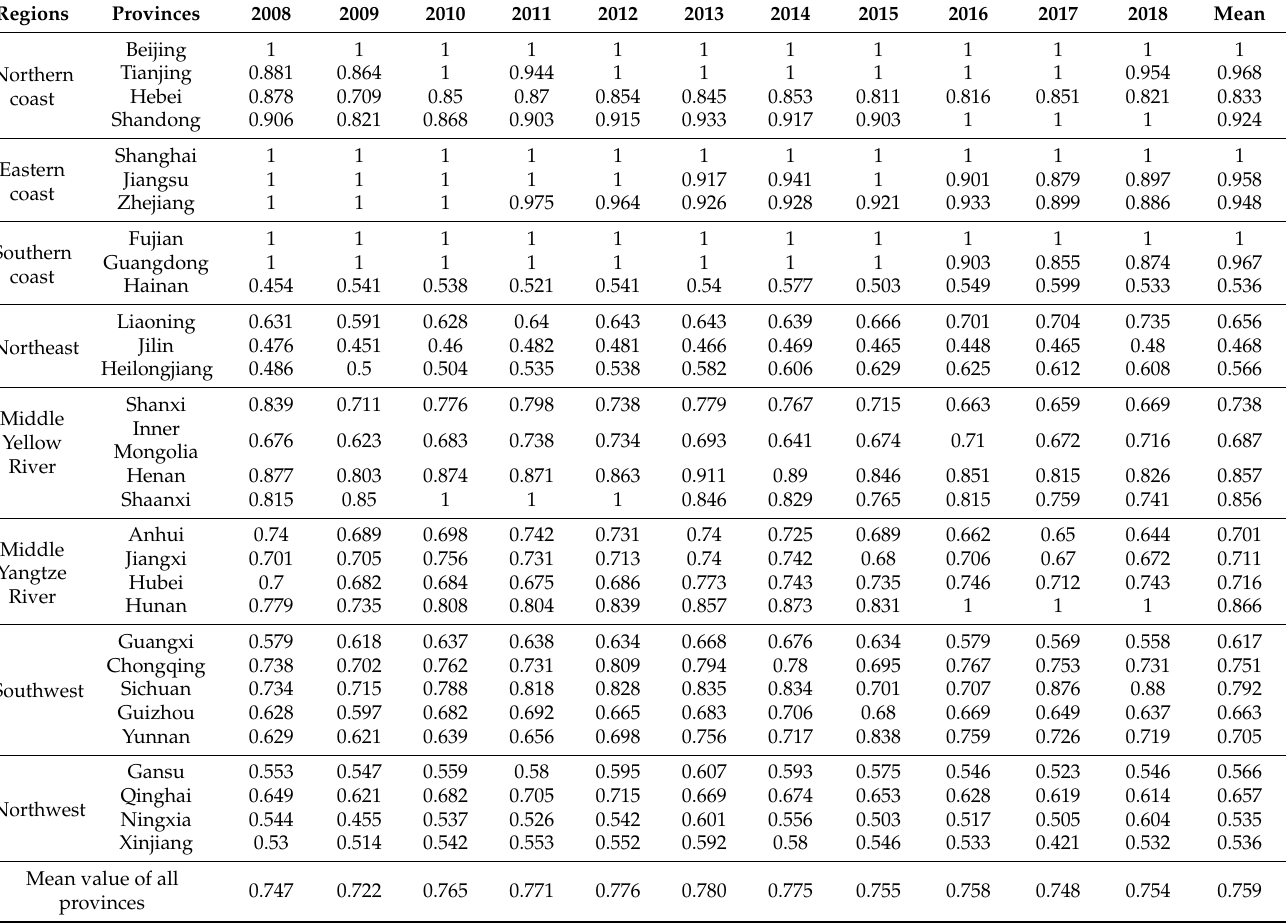
Table 4. The values of ULGUE for 30 provinces in China (2008–2018).